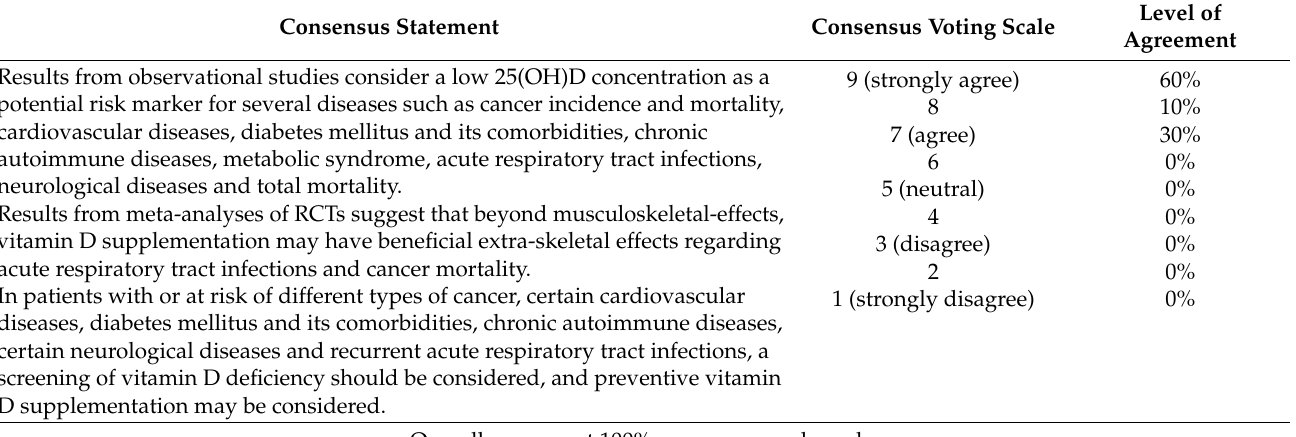
Table 8. Statement regarding extra-skeletal actions of vitamin D in adults.